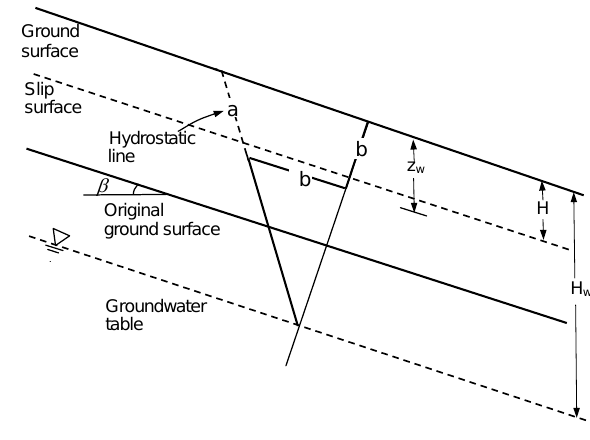
Fig. 8. Stability of an infinite loose soil deposit.